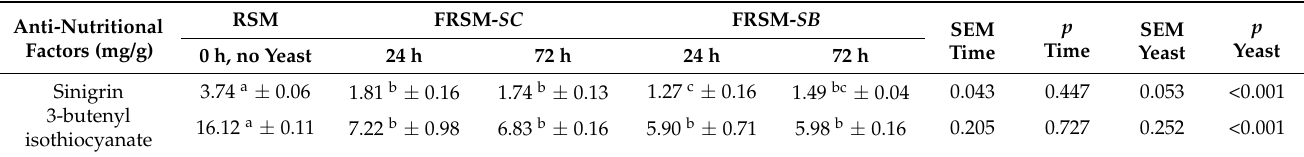
Table 1. The total intact glucosinolates and 3-butenyl isothiocyanate content in rapeseed meal samples.